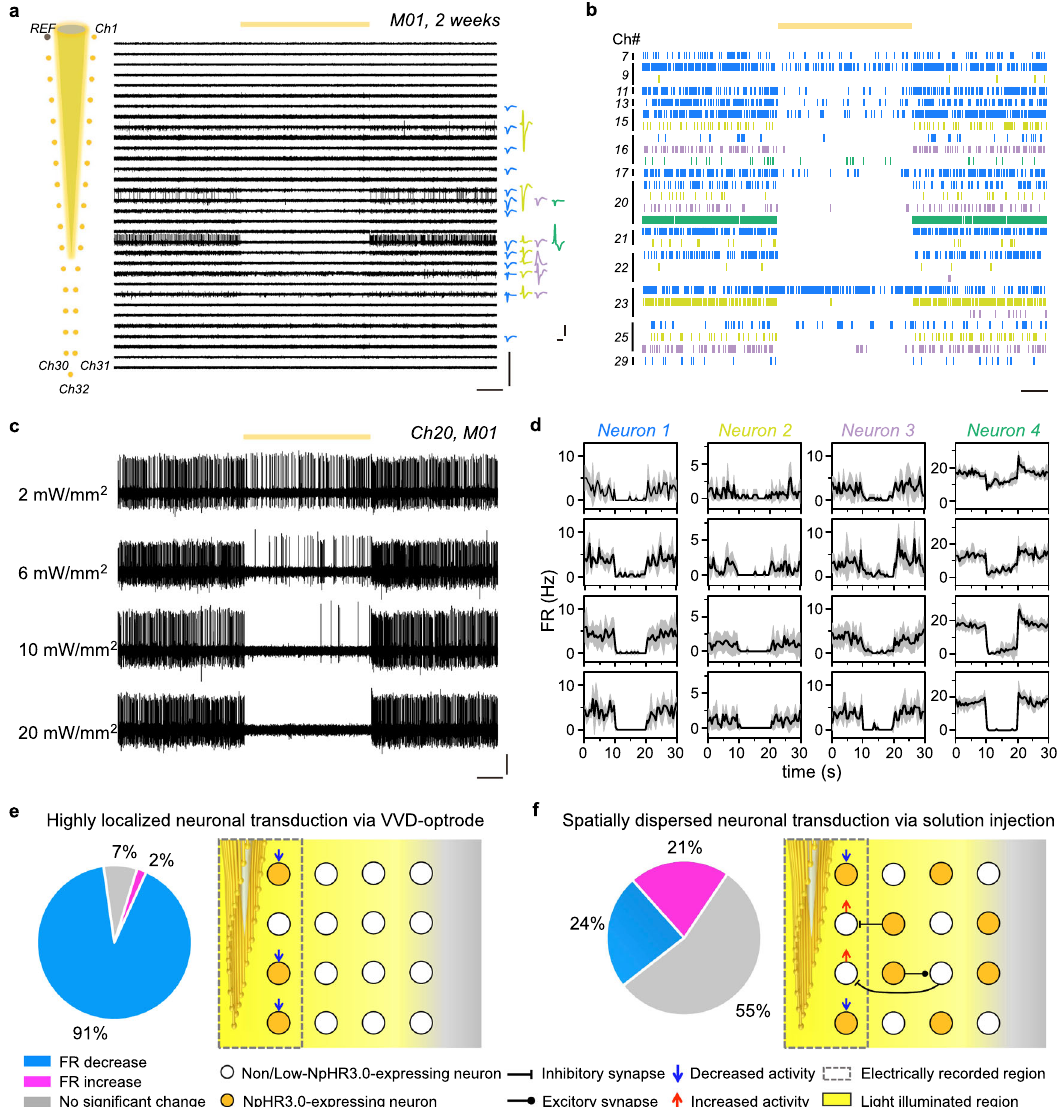
Fig. 3 Electrical recording during optogenetic inhibition of eNpHR3.0-expressing neurons. a AP traces were recorded in the M2/VO cortex of mouse M01 by an AAV9-hSyn::eNpHR3.0-delivery optrode at 2 weeks after implantation (left), from which 27 neurons were isolated (right). The yellow line indicates the duration of 10-s yellow light stimulation. Scale bar, 800 μ V (vertical, left), 2 s (horizontal, left), 100 μ V (vertical, right), and 1 ms (horizontal, right). b Spike rasters of 27 neurons in M01 during yellow light stimulation. Scale bar, 2 s. c AP traces were recorded by an example channel (Ch20) in response to 10-s yellow light stimulation at 2 – 20 mW/mm 2 . Scale bar, 100 μ V (vertical) and 2 s (horizontal). d Averaged fi ring rates of neurons recorded by Ch20 under 2 – 20 mW/mm 2 stimulation (from up to down). The fi ring rates were binned at 2 Hz. e , f Percentage of neurons with a decrease or an increase in fi ring rates during 20-mW/mm 2 stimulation ( n = 2 mice in each group). Neurons were transduced with eNpHR3.0 via VVD-optrodes in ( e ) and solution injections in ( f ), respectively. The right panels are schematics showing the neuronal transduction characteristics of AAV-delivery probes and conventional solution